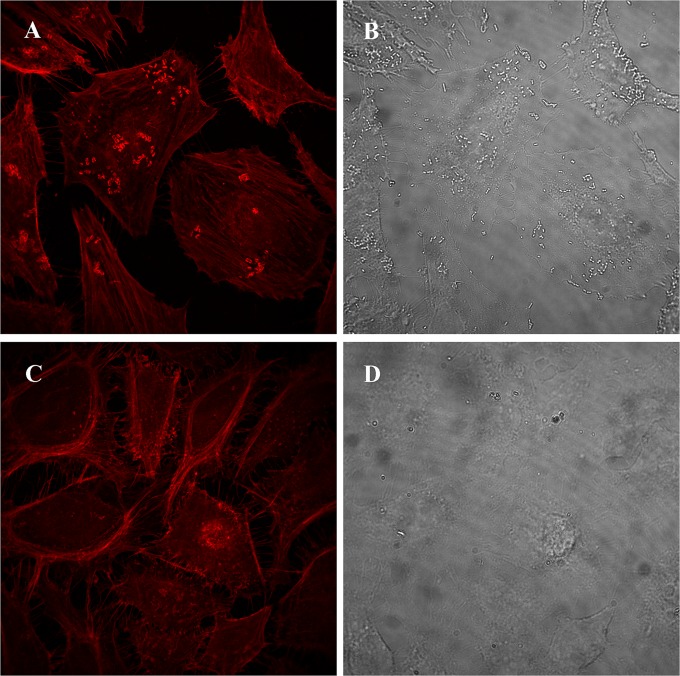
Effect of Escherichia coli O157:H7 on F-actin in HeLa cells. (A and B) HeLa cells infected by the exponential-phase cells. (C and D) HeLa cells infected by the VBNC cells. Left images, fluorescence micrographs; right images, phase-contrast micrographs.